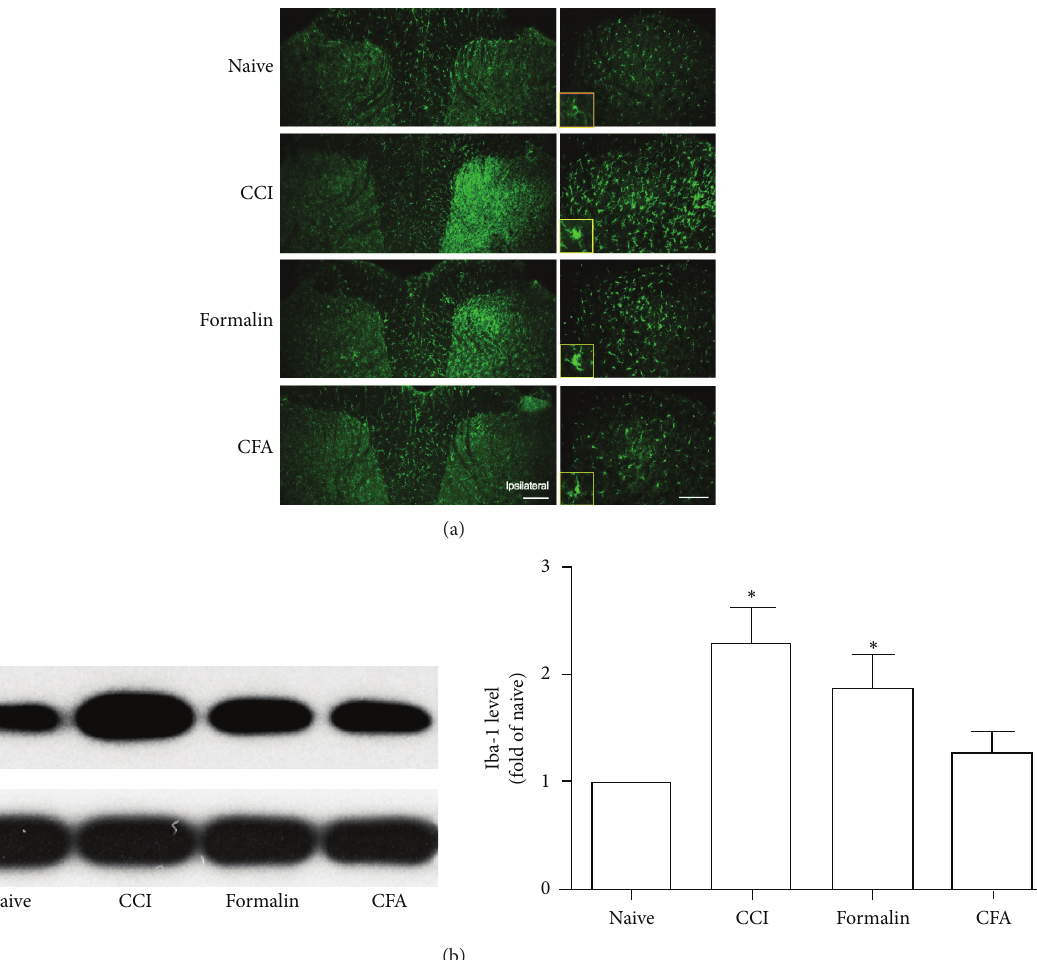
Figure 1: OX-42 and Iba-1 immunoreactivity in the spinal cord dorsal horn after different treatment to rats. A significant increase of OX- 42 and Iba-1 expression was present following CCI injury and formalin injection, which was accompanied with obvious morphological change compared with na¨ıve group ((a); Scale bar, 200 𝜇 m). The magnified images in yellow box showed the morphology of a single-activated microglia. Representative bands and quantification of western blot analysis (b) showed increased Iba-1 protein level in the lumbar spinal cord after CCI injury and formalin injection, not after CFA injection. ∗ 𝑃 < 0.05 , one-way ANOVA and Tukey post hoc test, compared with the na¨ıve (no treatment) control, 𝑛 = 4